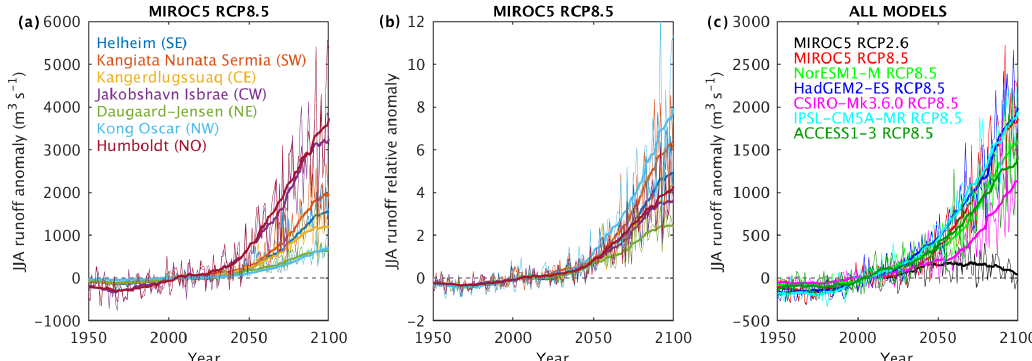
Figure 7. Projected subglacial runoff. For clarity, annual values are plotted as thin lines and 20-year running means are plotted as thicker lines. (a) Absolute runoff anomaly (difference from the 1995–2014 mean) by sector in the MIROC5 RCP8.5 simulation. For each sector, the runoff anomaly for the largest glacier by ice flux in that sector is plotted (locations in Fig. 3b). (b) Runoff anomaly normalised by the present- day value for the same glaciers (absolute anomaly divided by the 1995–2014 mean). The legend is the same as for (a) . (c) Representative runoff anomaly per CMIP AOGCM to illustrate model spread. The representative runoff anomaly is calculated as the mean over the seven glaciers shown in (a) . Full plots for all sectors and models may be found in Figs. S4 and S5.